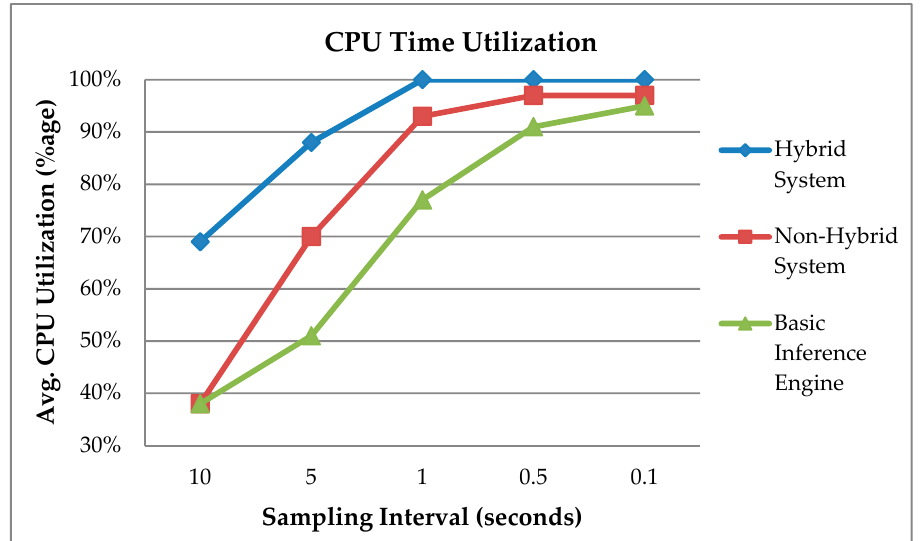
Figure 13. Average CPU time utilization.